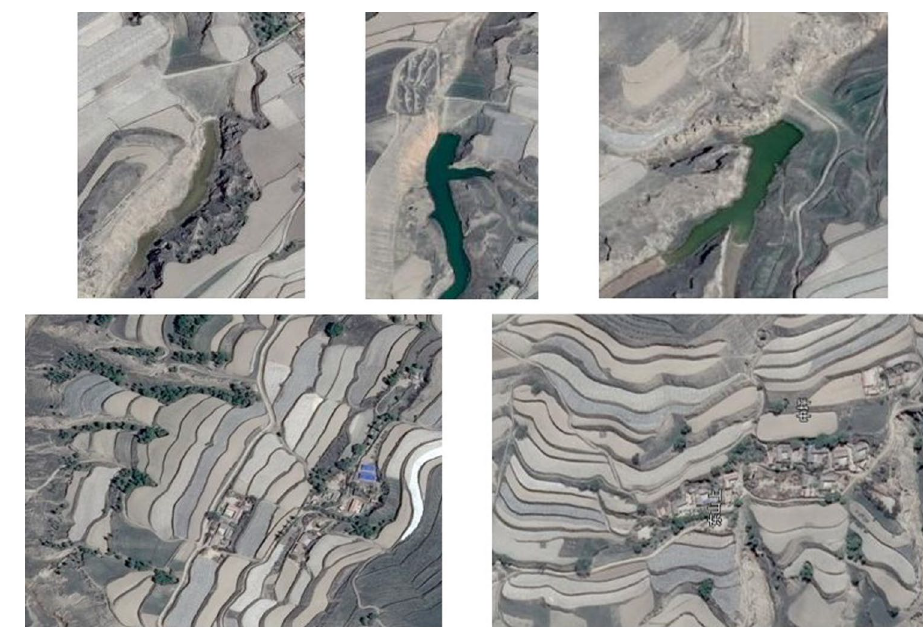
Fig. 6 Examples of the check dams and terraces identified from the remote sensing images in the Chenggou River Basin